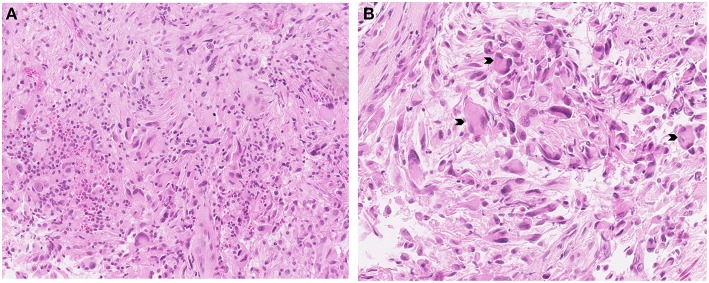
Astrocytic glial cell population with grouped ganglion cells, marked in hematoxylin-Eosin-Saffron staining (original magnification X18) (A), neuronal components characterized by larger numbers of binucleated or multinucleated cells (arrowheads) with a cellular glial background evaluated by hematoxylin-Eosin-Saffron staining (original magnification X28) (B).